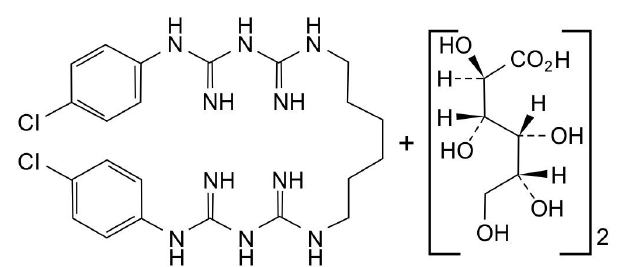
FIGURE 1 - Chemical structure of chlorhexidine digluconate (CAS: